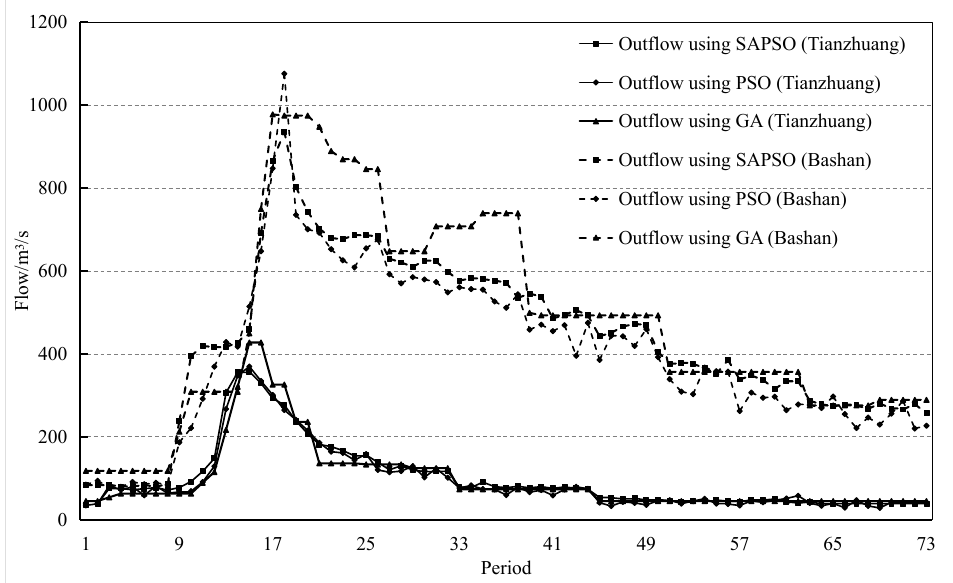
Figure 9. Outflow hydrographs for the 31 July 1964 flood using the SAPSO, PSO, and GA algo- rithms.